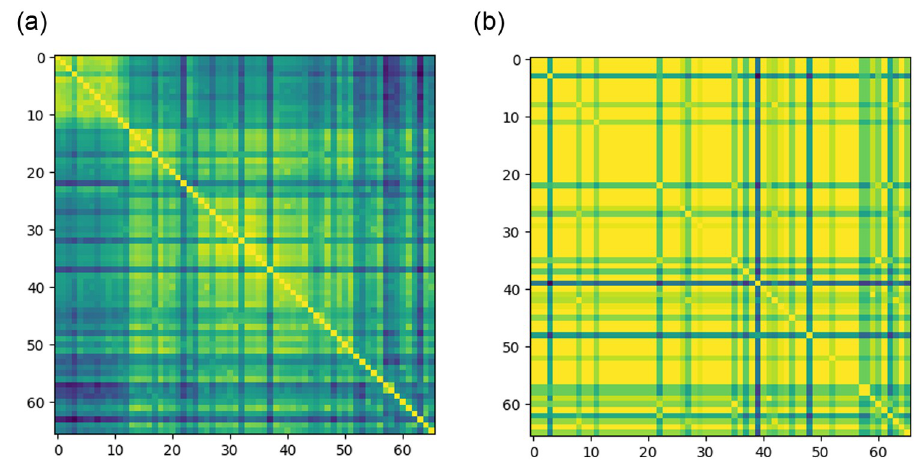
Fig 7. Color map visualization of similarity matrices of the Mammals metabolism experiment: Lighter colors correspond to organisms with high degree of similarity (from yellow to blue). Rows and colums are labeled according to the organisms ids 0–65 listed in S1